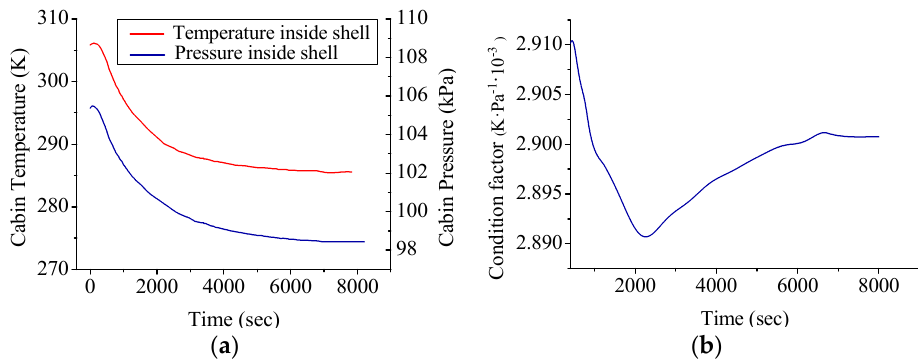
Figure 7. Development of cabin atmosphere during diving profile process of #52 ROV task. ( a )